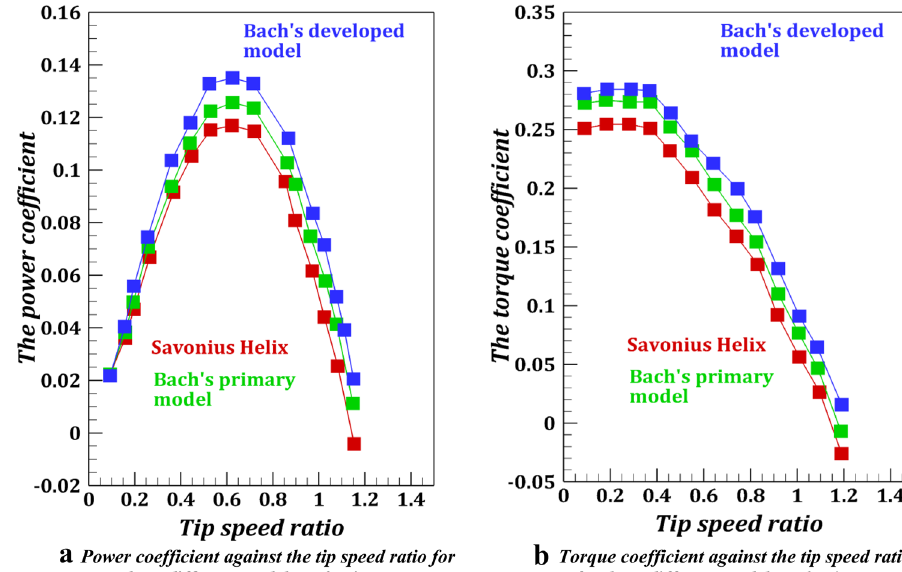
Fig. 9 a Power coefficient against the tip speed ratio for three different models at 6 m/s; b Torque coefficient against the tip speed ratio for three different models at 6